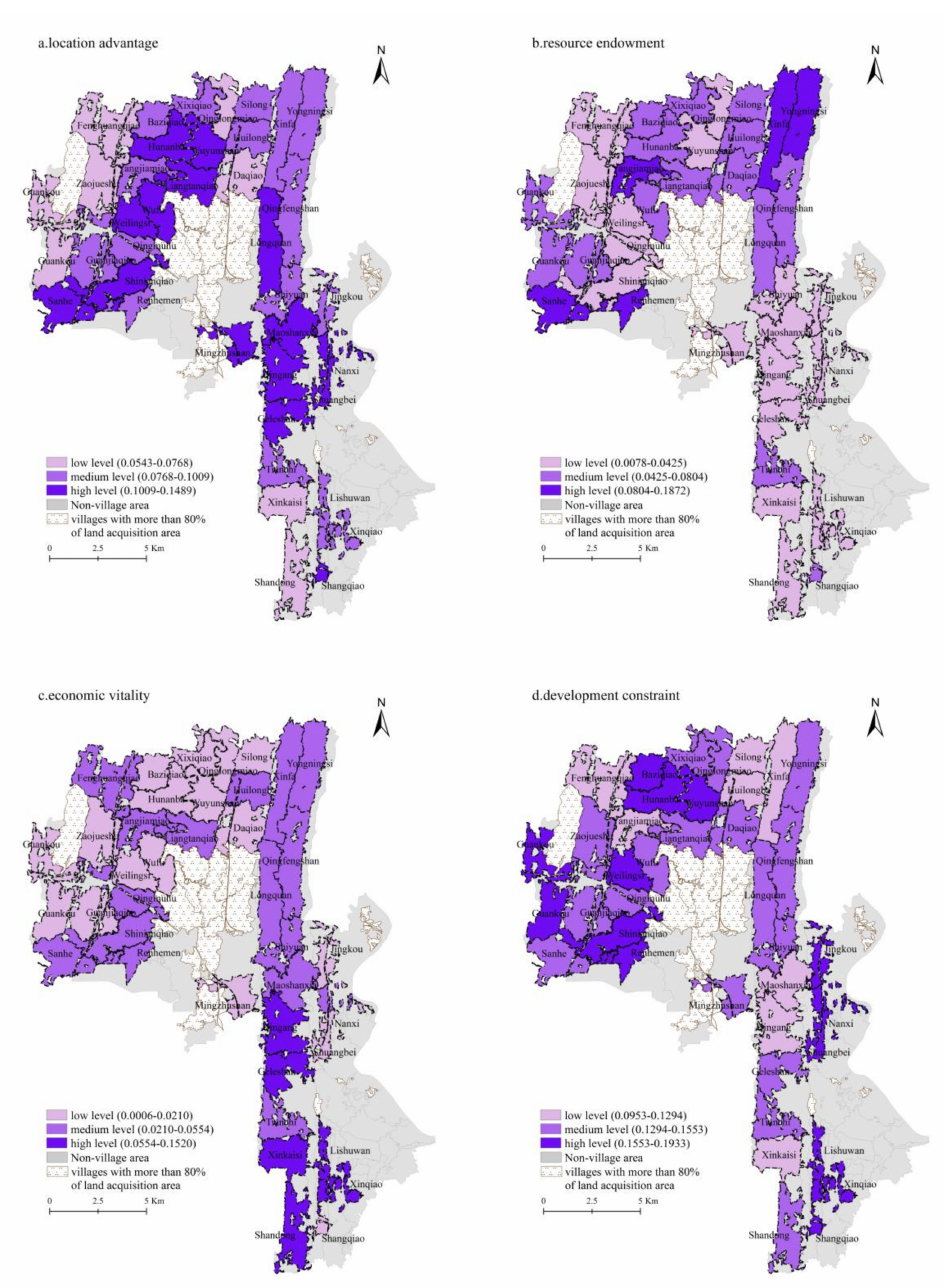
Figure 4. Distribution of rural development